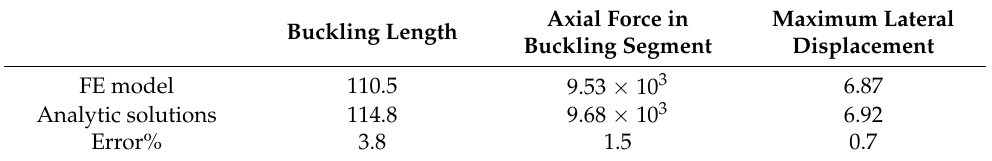
Table 10. Comparison of the